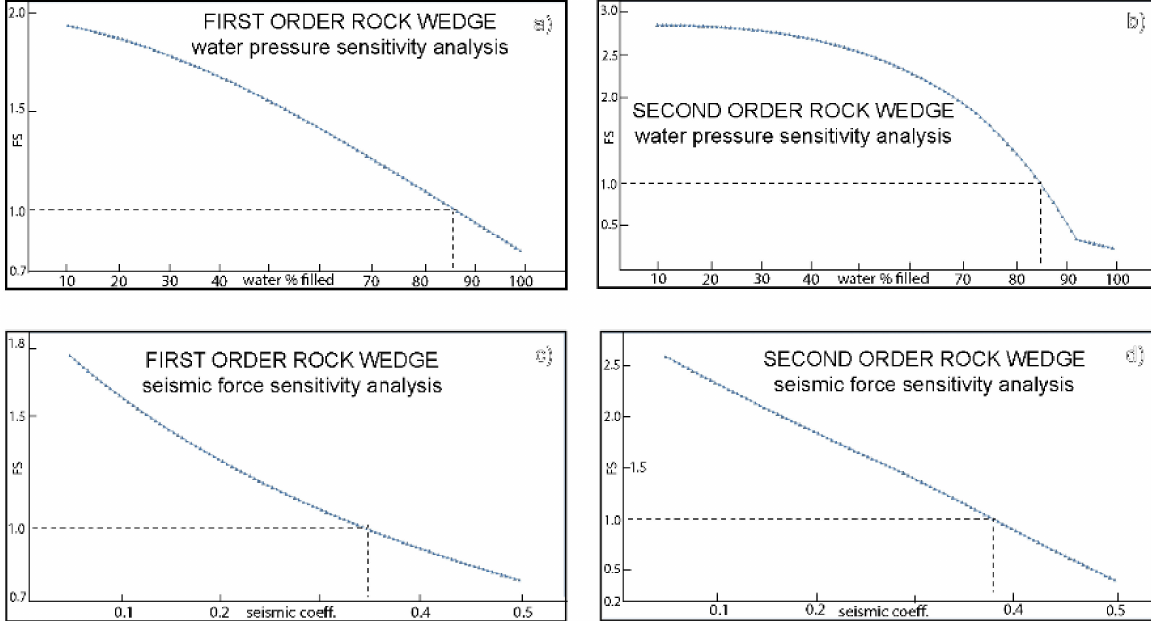
Figure 13. Sensitivity plots: ( a ) FS versus Water Percent Filled for first-order rock wedge; ( b ) FS versus Water Percent Filled for second-order rock wedge; ( c ) FS versus Seismic Coefficient for first-order rock wedge; ( d ) FS versus Seismic Coefficient for second-order rock